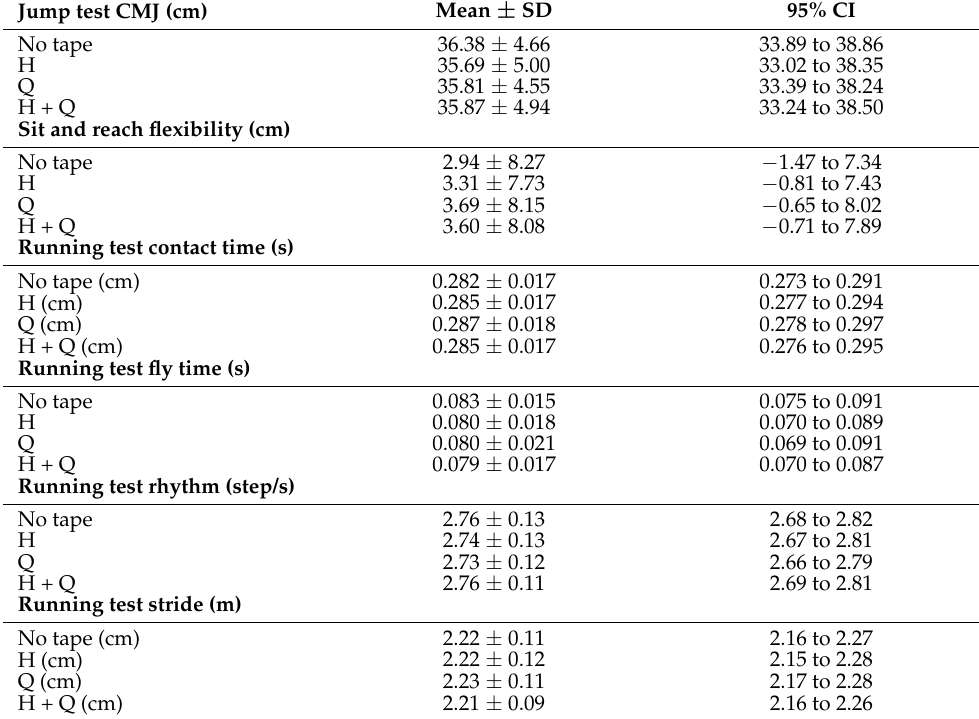
Table 1. Data for the jump test, sit and reach test, and running test are expressed as mean ± SD and 95% confidence